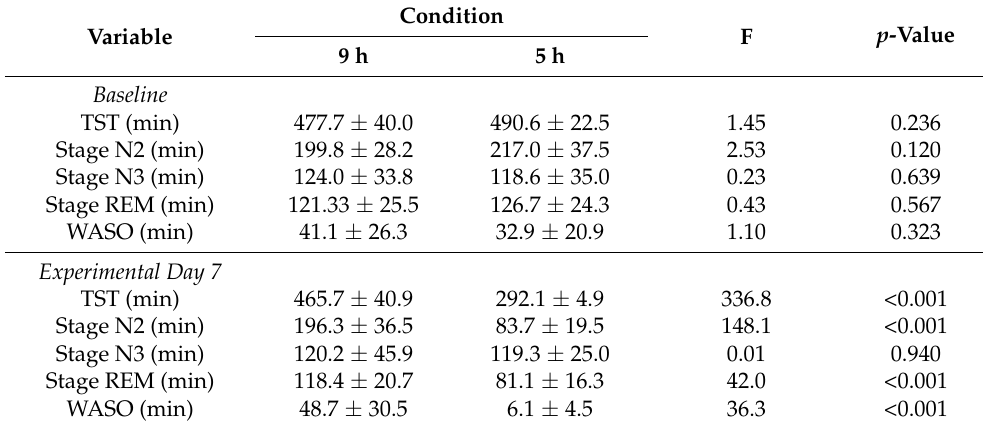
Table 2. Sleep characteristics at baseline and on experimental day E7 in the 9 h and 5 h